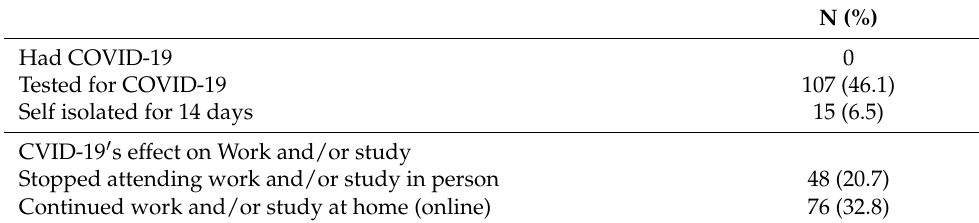
Table 4. COVID-19 (cid:48) s influence on mental health, eating disorders and quality of life (N =